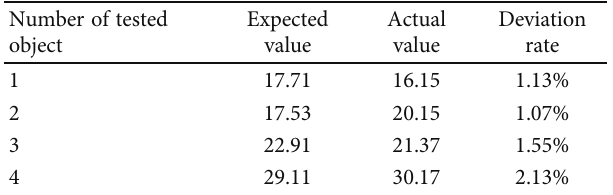
Table 4: Colorimetric sensor array identi fi cation processing results and expected di ff